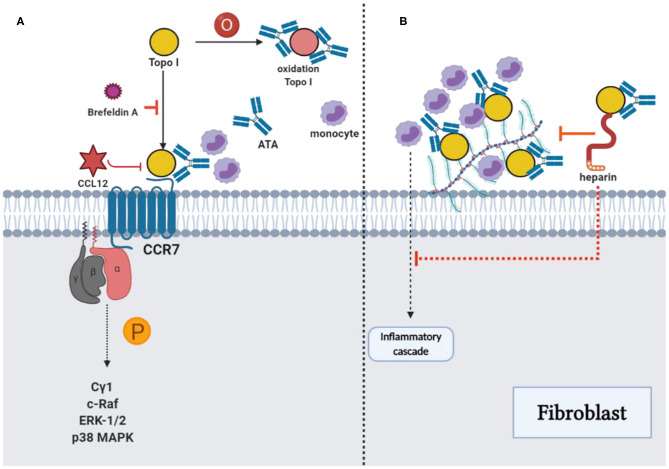
ATAs and topo I: Reinforcement of pathological functions. (A) The combination of TOPO I and fibroblasts could be suppressed by using brefeldin A, and oxidized TOPO I may have increased the antigenicity. The potential intracellular signaling pathway stimulated by TOPO I was the phosphorylation of phospholipase Cγ1, c-Raf, ERK-1/2, and p38 MAPK, which stimulated the migration of fibroblast. Cytokine-like effects of TOPO I in the pathway could be inhibited by CCL21. (B) TOPO I bound to HS proteoglycans on the fibroblast surface, as well as the accumulation of TOPO I on cell surfaces by ATAs could contribute to the initiation of an inflammatory cascade stimulating the fibrosis. The effect could be inhibited by heparin through the interference with TOPO I binding and the consequent accumulation of TOPO I-ATA ICs could be restrained with decreased monocyte adhesion, proinflammatory factors, and fibrosis.